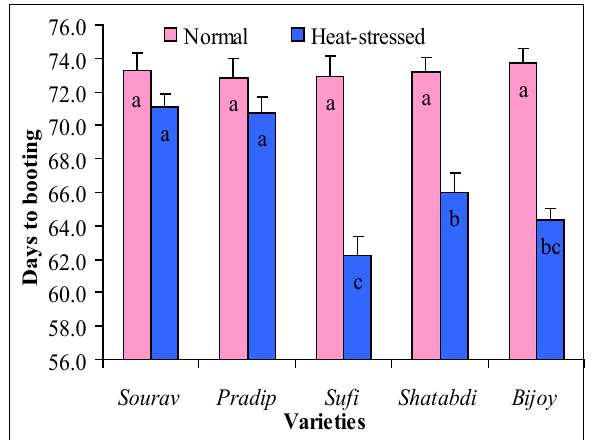
Fig. 2. Differences in days to germination of different wheat va- rieties under normal and heat stressed condition. Mean (±SD) was calculated from three replicates for each treatment. Bars with different letters are significantly different at P < 0.05 ap-